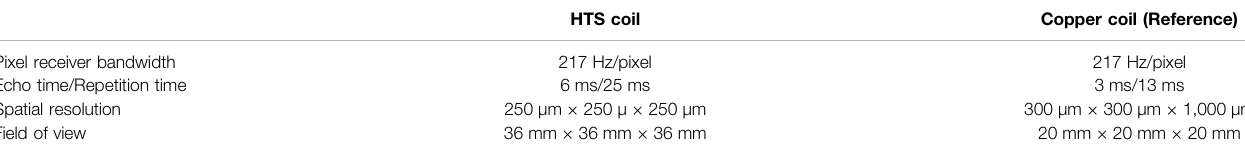
TABLE 1 | Acquisition parameters of the 3D gradient-echo MRI sequence used in Setup 2.